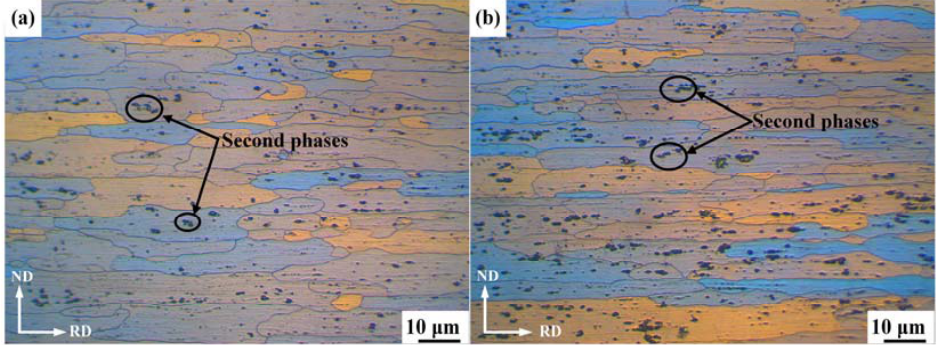
Figure 3. Optical images of 2519A aluminum alloy along the thickness direction: ( a ) Surface layer; ( b ) Middle layer.